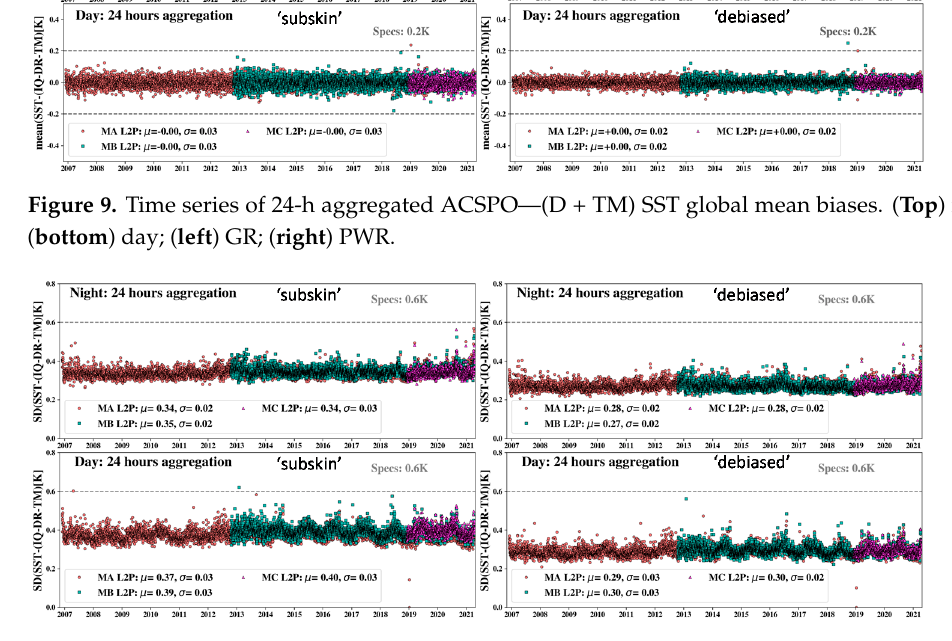
Figure 10. Same as in Figure 9 but for the global standard deviations (SD).